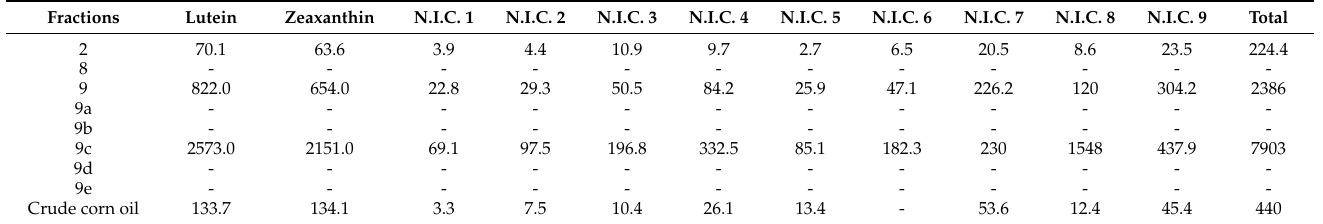
Table 3. Free carotenoids in fraction 2 and in high-polarity corn oil fractions 8, 9 and 9a–e after SPE fractionation strategy. Values are expressed as µ g/g.